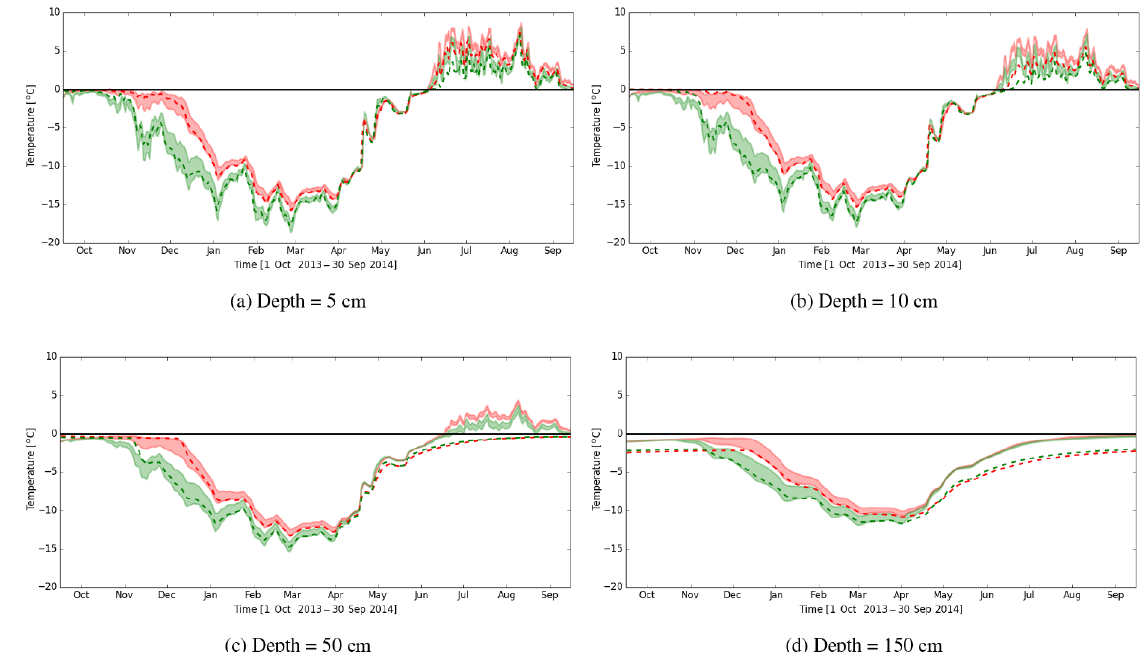
Figure 10. Simulated vs. observed soil temperatures at Site D at depths 5, 10, 50 and 150cm show bias in the model in deeper soil and during the warm summer season. Dotted lines represent observed data at center (in red), rim (green) and trough (blue) locations, while shaded curves show mean ± standard deviation of simulated daily soil temperatures across the domain.